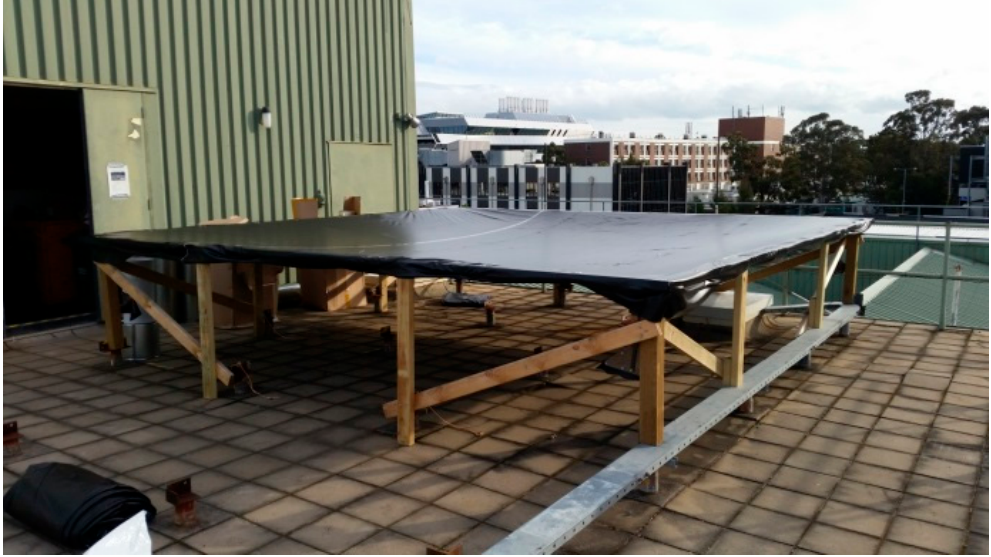
Figure 24. Photograph of the rooftop membrane.